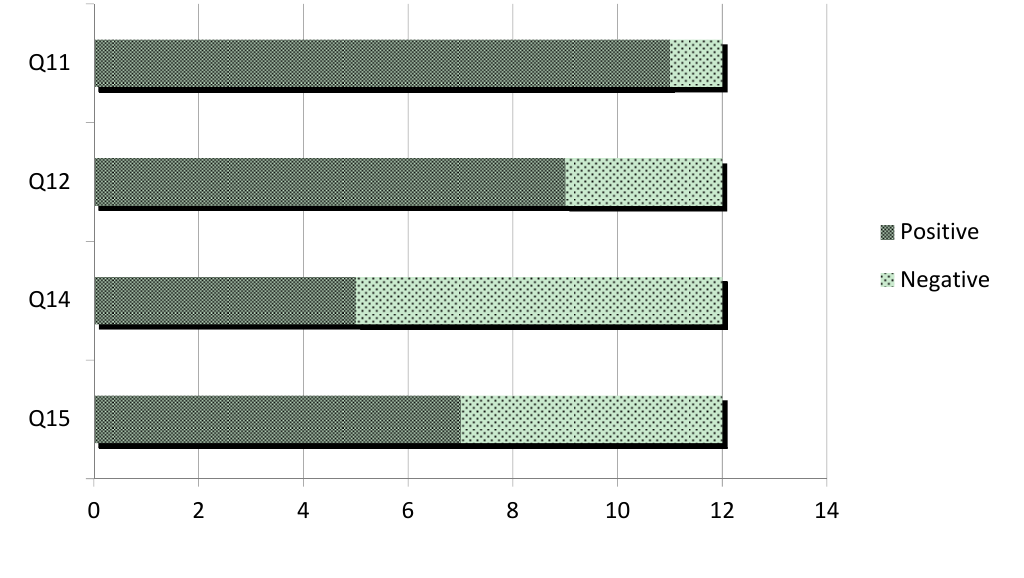
Table 5. Statements and results for the fourth part of the questionnaire